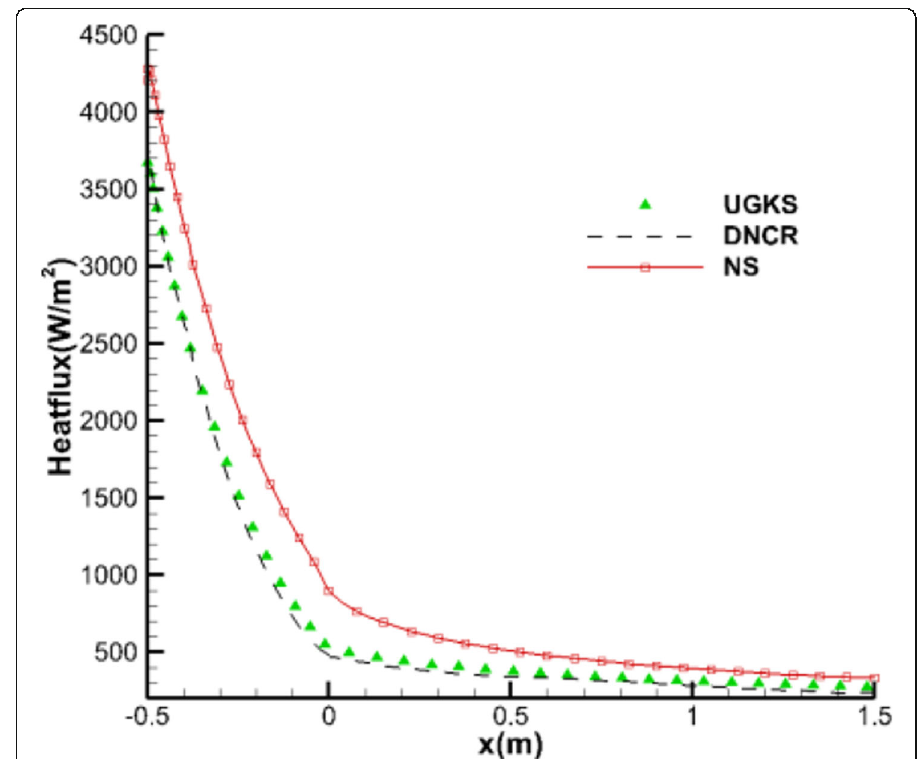
Fig. 14 Heat flux distribution along the upper